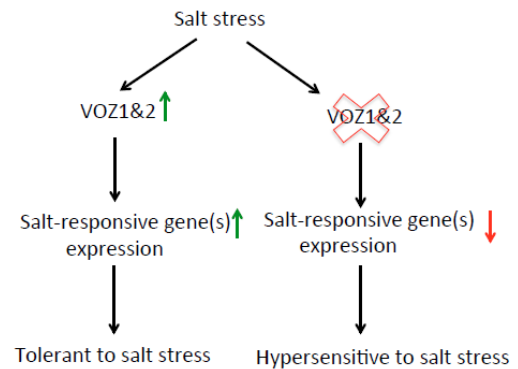
Figure 10. A proposed model for the role of VOZs in salt stress response (see text for details). Green and red arrows indicate the increased and decreased expression levels, respectively.